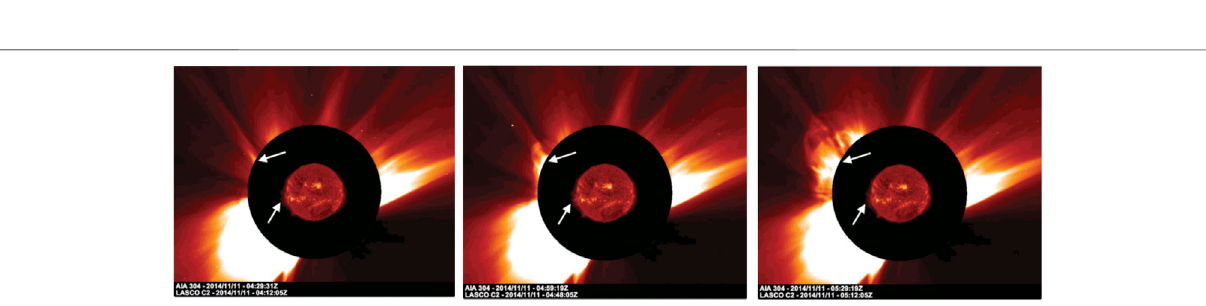
Frontiers in Astronomy and Space Sciences |